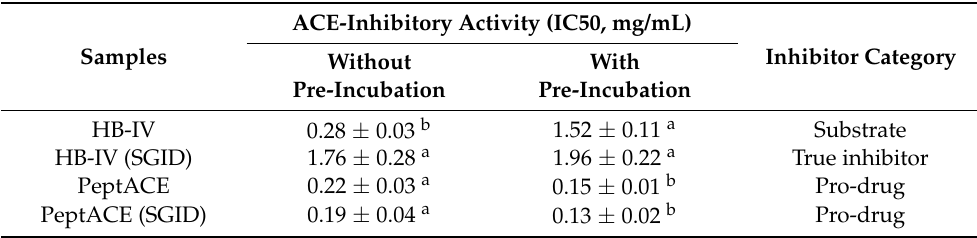
Table 6. ACE-inhibitory activity of HB-IV and PeptACE with and without pre-incubation with ACE. ACE-Inhibitory Activity (IC50, mg/mL) Samples Inhibitor CategoryWithout With Pre-Incubation Pre-Incubation HB-IV HB-IV (SGID) PeptACE 0.22 ± 0.03 a Pro-drug PeptACE (SGID)